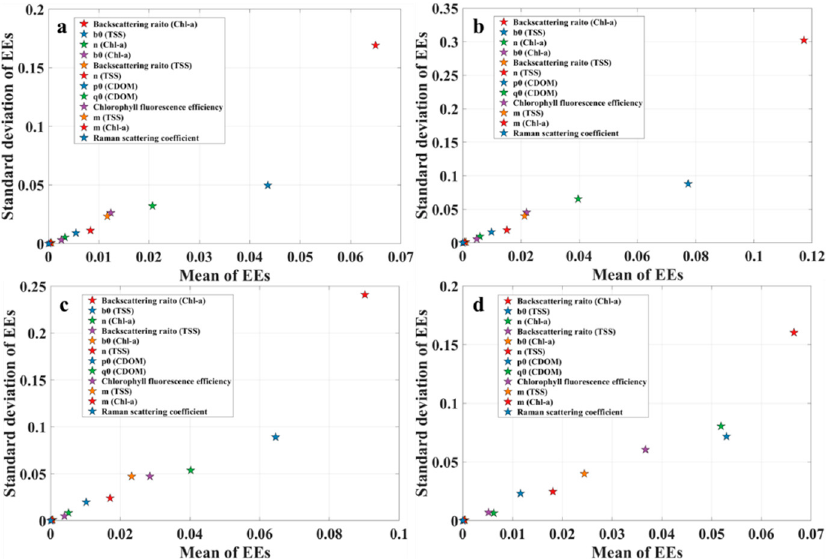
Figure 5. Sensitivity analysis results for the CS region—( a ) is the parameter sensitivity result at the level of surface water; ( b ) is the sensitivity result at the subsurface; ( c ) is the sensitivity result at a depth of 0.5 m; and ( d ) is the sensitivity result at depth of 1.0 m.